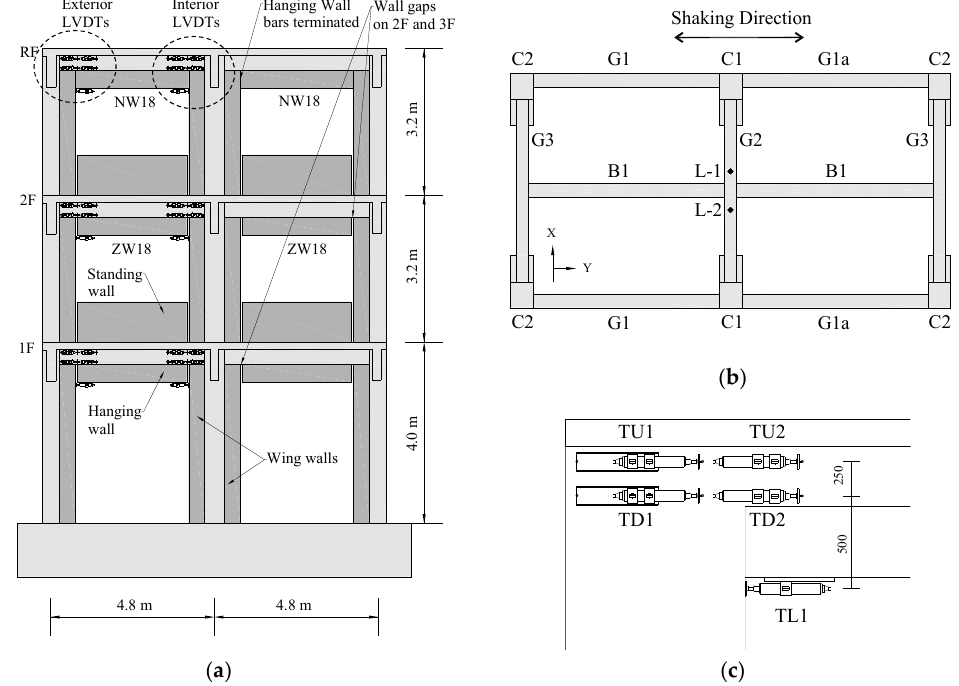
Figure 15. E-defense specimen: ( a ) in-plane frame; ( b ) floor plane; ( c ) exterior LVDTs.